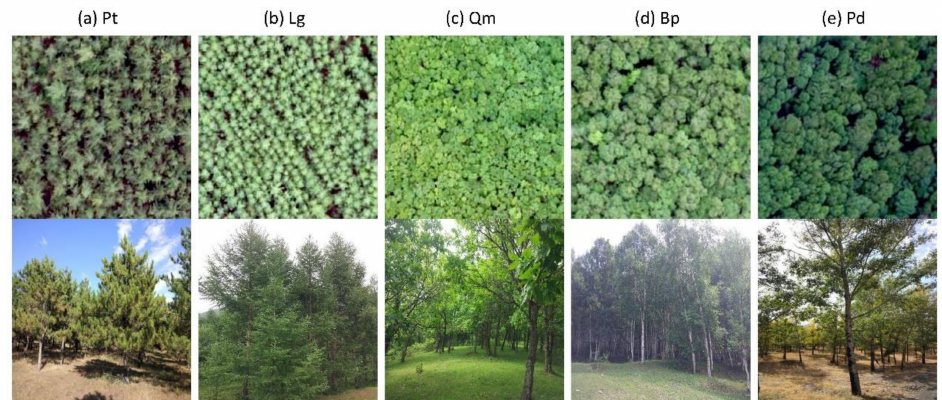
Figure 2. The canopy images of five dominant tree species taken by unmanned aerial vehicle (UAV) during the summer of 2017 in the study region (upper panels), and the vertical structure of forest stand (bottom panels). The abbreviations of Pt ( a ), Lg ( b ), Qm ( c ), Bp ( d ), and Pd ( e ) stand for Pinus tabulaeformis , Larix gmelinii , Quercus mongolica , Betula platyphylla , and Populus davidiana,